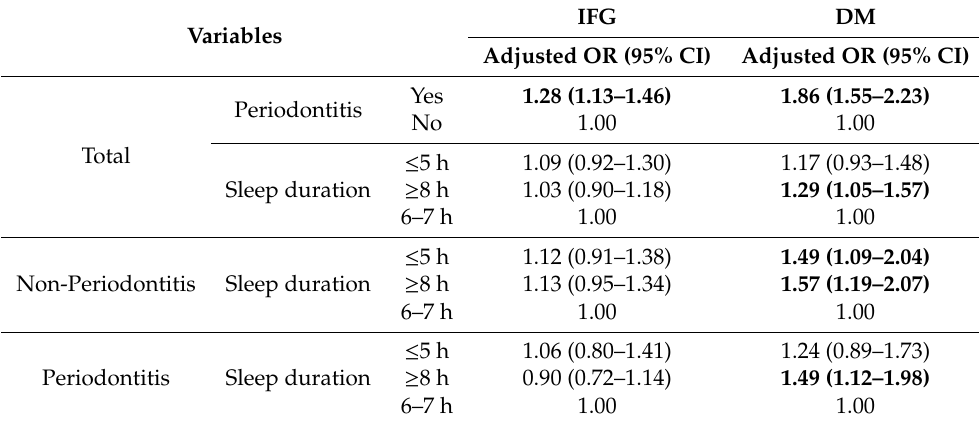
Table 4. E ff ect of sleep duration on fasting serum glucose and diabetes with periodontitis and